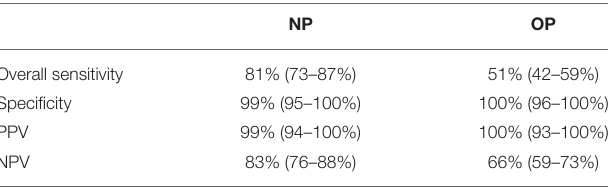
TABLE 2 | Test characteristics (mean, two-sided 95% confidence interval) of NG-Test ® SARS-CoV-2 Ag using nasopharyngeal (NP) and oropharyngeal (OP) samples (each of 263).